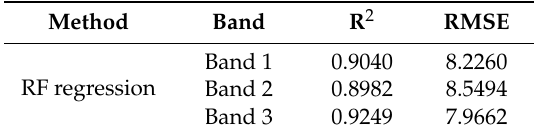
Figure 6. Scattergram of Band 1, Band 2 and Band 3 between normalized subject image generated by RF regression and reference image. Table 4. Statistical results (R 2 and RMSE) of RF regression normalization.